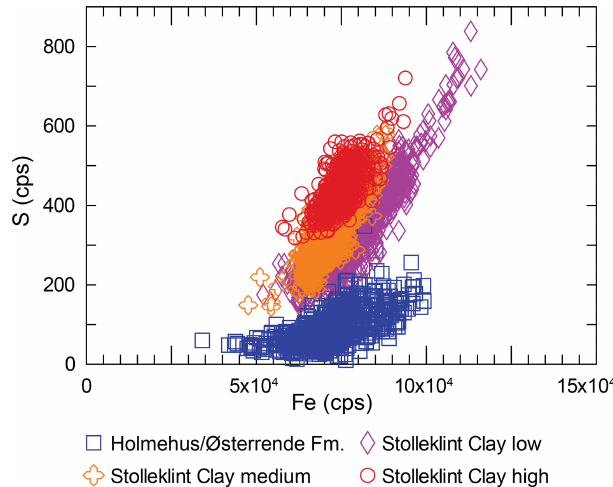
Figure 8. Biplot of Fe and S. Data from XRF element core scans of all four box cores; cps: counts per